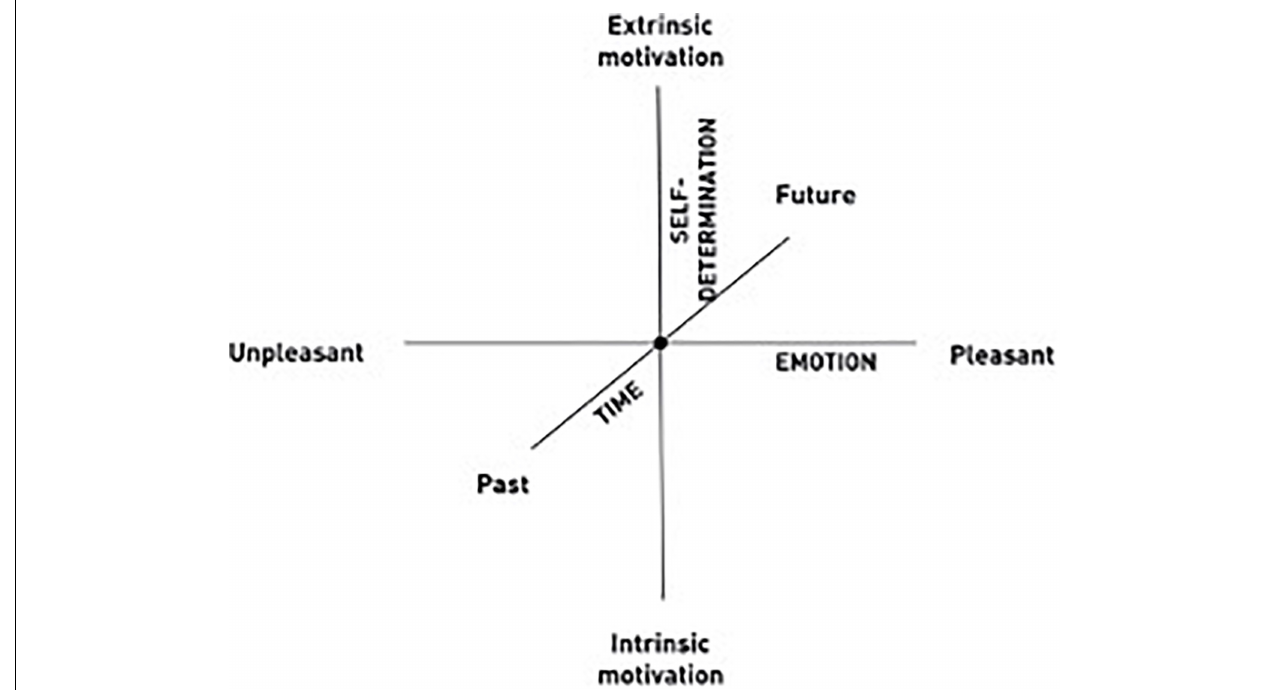
FIGURE 1 | The axes of the Sphere Model of Consciousness. The Place of Pre-Existence (PPE) is placed at the intersection of the three axes in the center of the sphere. Adapted from Paoletti (2002a) and Paoletti and Ben-Soussan